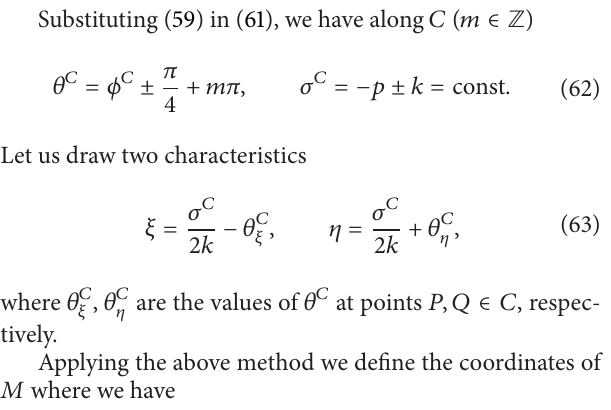
Substituting (59) in (61), we have along 𝐶 ( 𝑚 ∈ Z